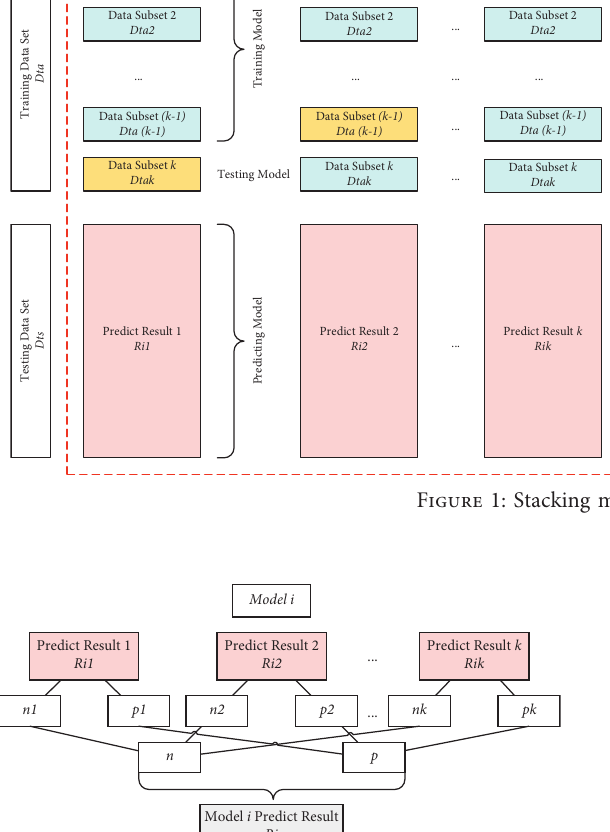
Figure 2: Stacking classification method of the second-level learner